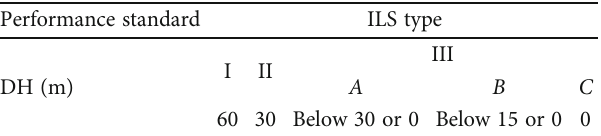
Table 1: Classi fi cation and performance standards of the three ILS